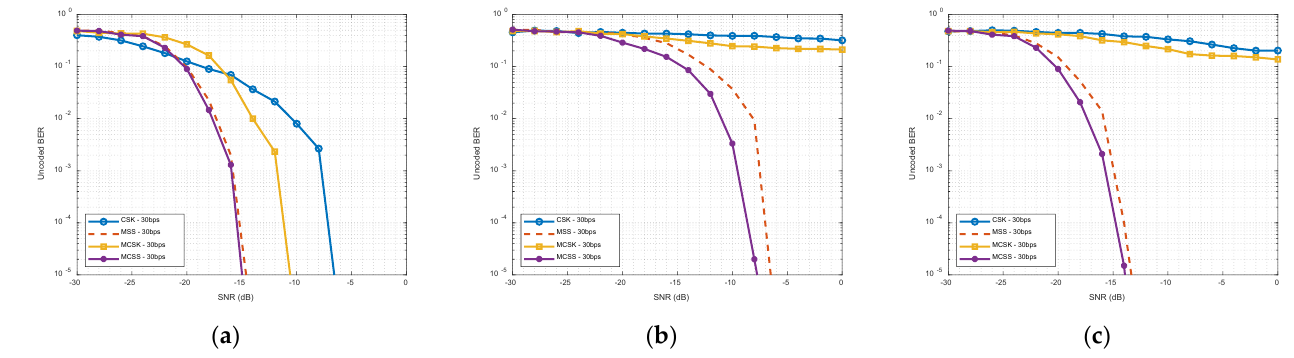
Figure 11. BER performance at the same bit rate. ( a ) is when there is no artificial Doppler shift, ( b ) is with Doppler and no compensation, ( c ) is when Doppler is compensated.